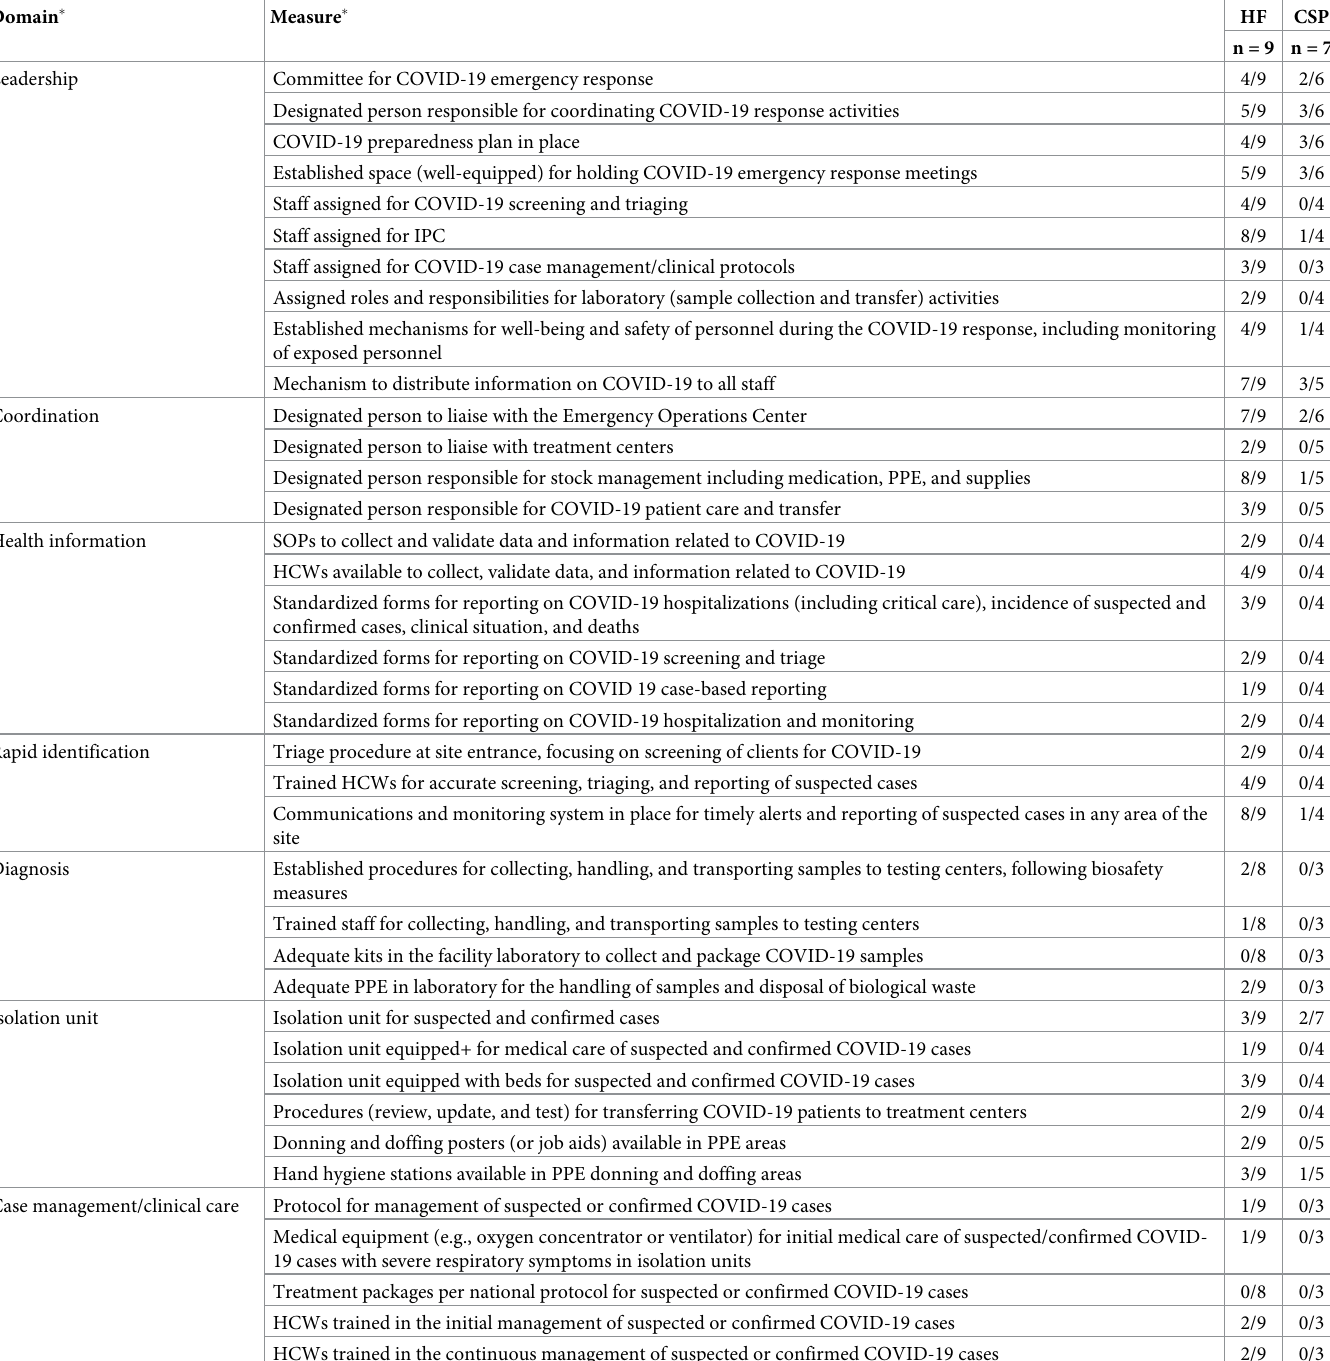
Table 1. COVID-19 preparedness measures by domain and site type. Domain